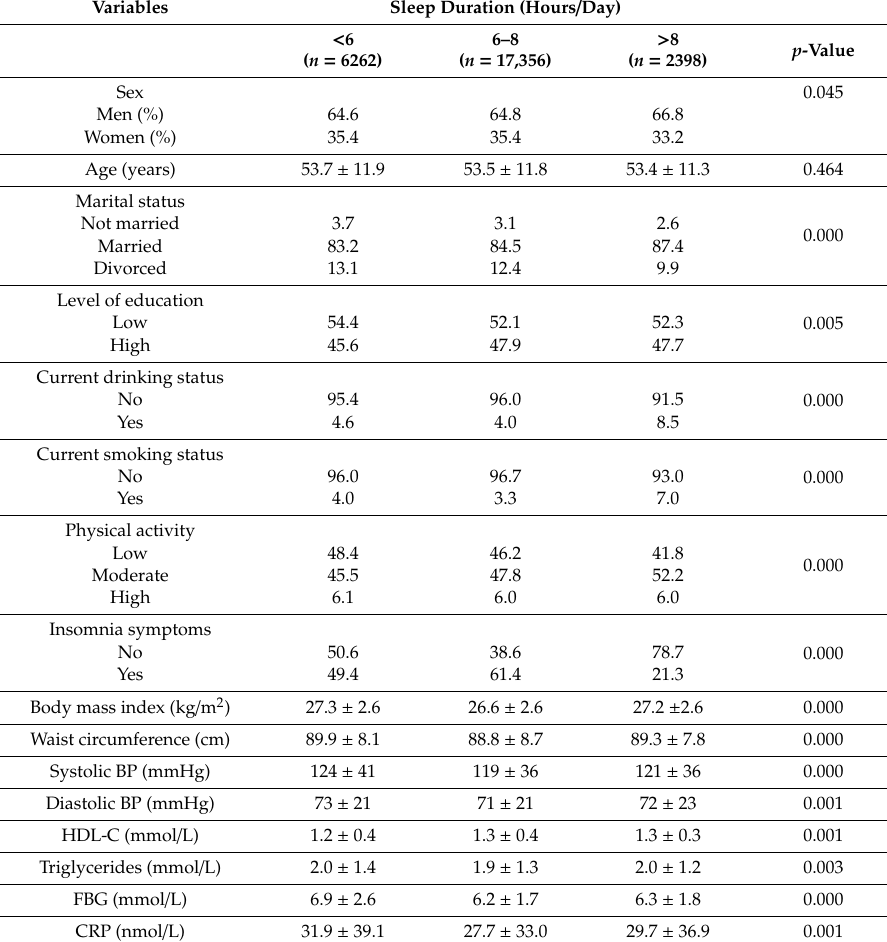
Table 1. Characteristics of the volunteers across sleep duration.